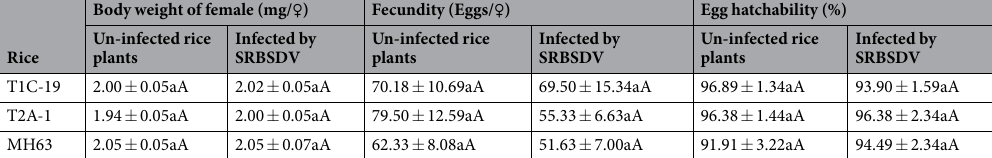
Table 7. Effects of transgenic rice plants infected with SRBSDV on the body weight, fecundity of female adult BPH and egg